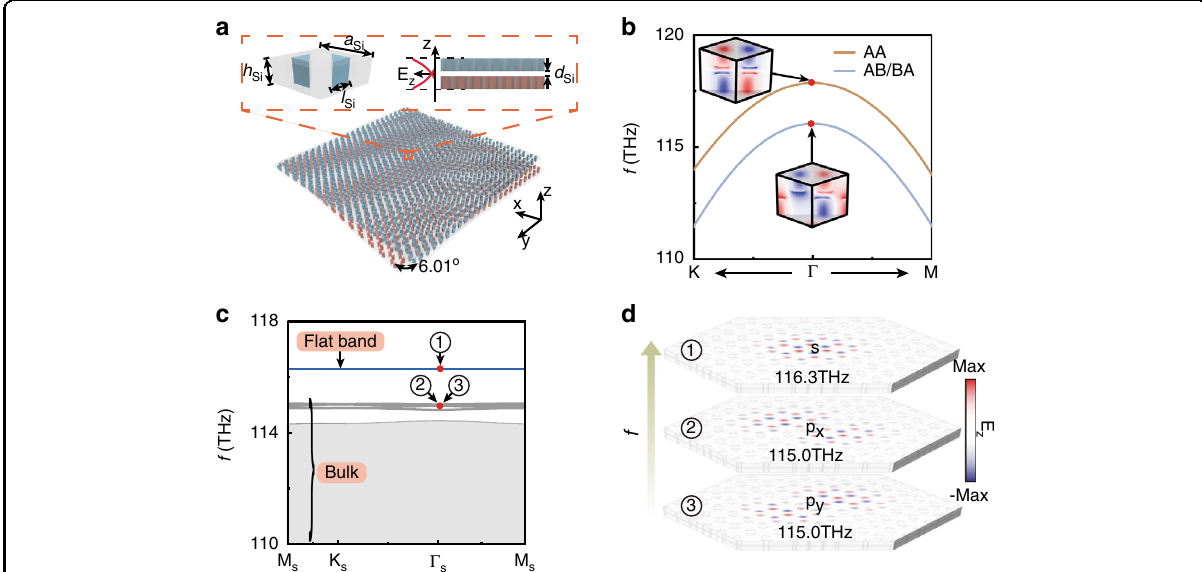
Fig. 6 Nanophotonic design and results for the super fl at band and localized state. a Schematic of twisted bilayer PCs made of silicon and air materials, with graphene-like lattices in each slab. The left inset displays the three-dimensional unit cell structure of single layers. The right inset presents the cross section of twisted bilayer PCs and the amplitude (E z ) of fundamental modes along the z direction. b Band structures of AA and AB/ BA stacked PCs near Γ point. The eigenfrequencies for AA stacked PCs are signi fi cantly greater than that of AB/BA stacked PCs under the same essential parameters (i.e., a Si , h Si , l Si , and d Si ). The insets represent the eigenstates with C 3 symmetry at Γ point. c Band structures of moiré superlattices with twist angle 6.01 ∘ . The super fl at band (blue) is separated from the rest of bands. d Typical eigenstates (E z ) of moiré superlattices at Γ S point of moiré BZs on the super fl at band and adjacent bands, i.e., s and p x , y states. s state exhibits well-con fi ned features with C 3 symmetries, leading to intrinsic super fl at bands. Non fl at bands composed of p x , y states are enumerated as the comparison. Eigenfrequencies and the corresponding electromagnetic fi elds are solved by